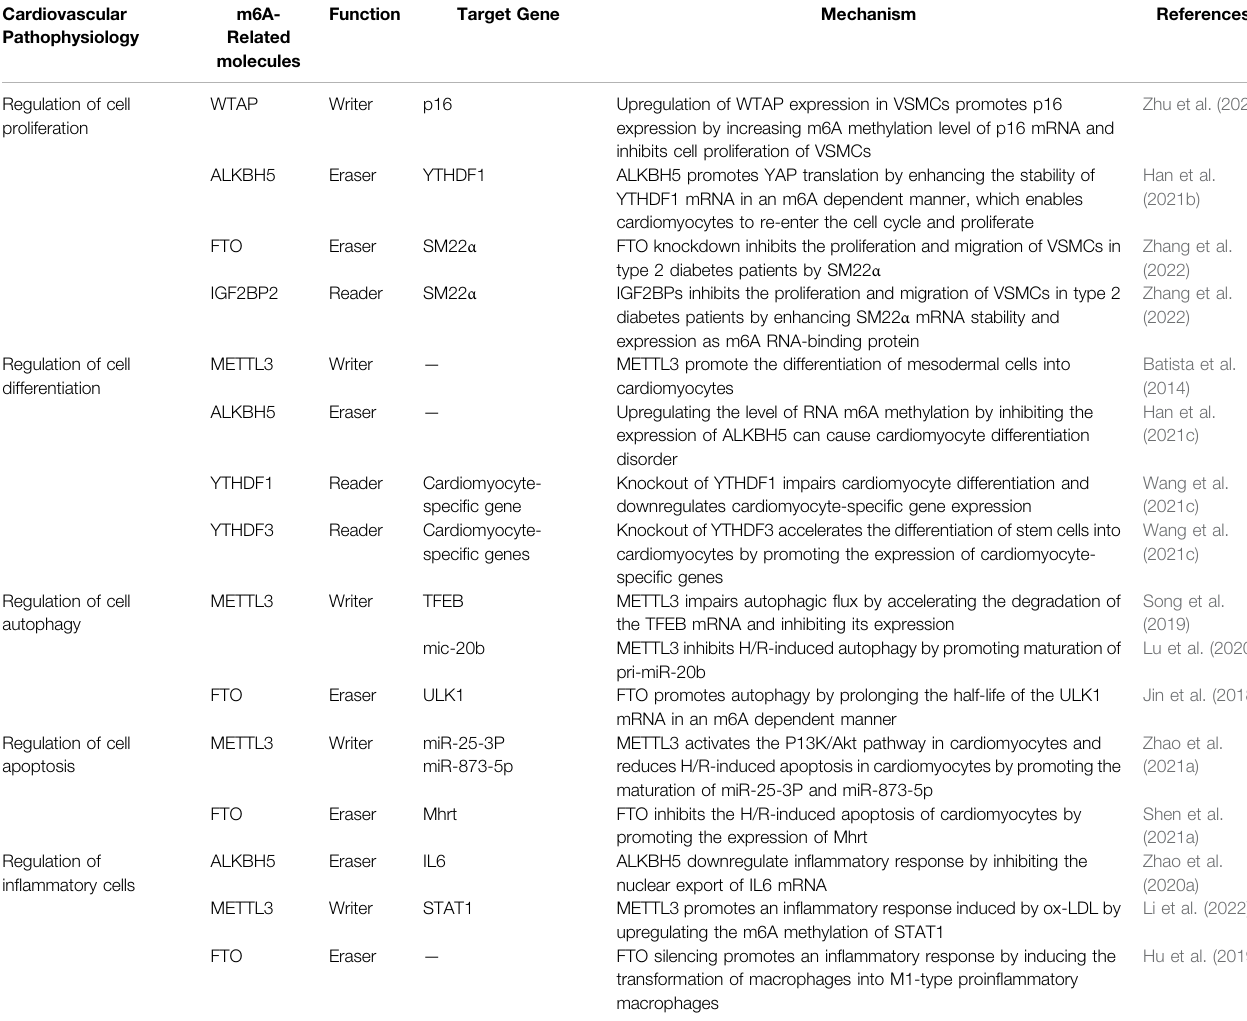
TABLE 1 | The role of m6A methylation in cardiovascular pathophysiology. Cardiovascular